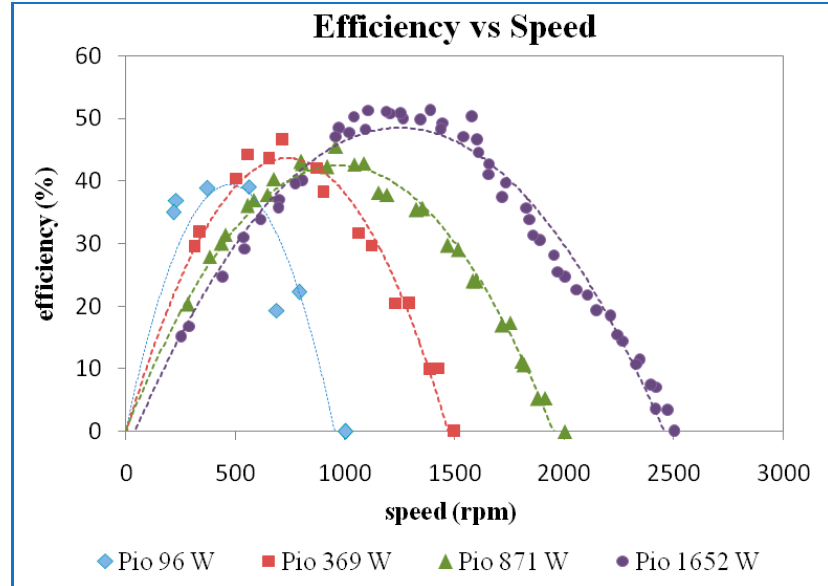
Figure 21. Torque vs. speed at a guide vane opening of 19 mm. From Figure 22, maximum efficiency is observed at 1652 W. Maximum efficiency observed at 871 W was higher compared to the 96 W and 369 W power inputs. Compared to all other guide vane openings, the 19 mm guide vane opening showed the best efficiency due to no obstruction and vibration compared to low guide vane openings. As per the standard of this turbine, it could not achieve more efficiency at 19 mm guide vane opening due to some of the drawbacks, such as leakages between the blades and the casing and vibrations of the turbine.